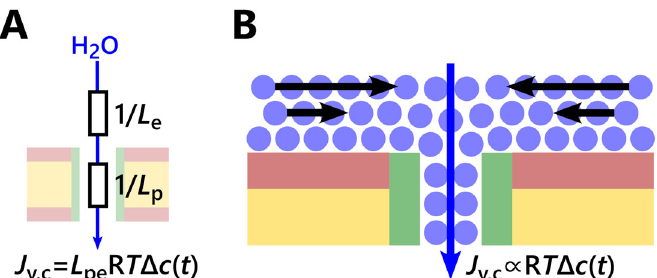
Figure 8. ( A ) Entrance effects may limit rapid water transport through selective water channels. The hydrodynamic resistance of the entrance region, 1/ L e , determines the rate at which water can be fed to the channel. 1/ L e is in series with the hydrodynamic resistance of the channel, 1/ L p , which is intrinsic to the channel and governed by interactions of intraluminal water molecules with the pore walls [14,34]. If L p exceeds L e , the water flux through the narrow channel, J v,c , is limited by L e (Equation (17)). ( B ) One way of rationalizing the access resistance for water is to consider the no-slip condition at the membrane–water interface. The further into the bulk, the more mobile the water molecules become, as indicated by the horizontal arrows. At the pore mouth, highly mobile water molecules are effectively depleted due to the osmotic gradient across the membrane, where R T ∆ c ( t ) is osmotic pressure across the vesicular membrane. Since (a) permeating water molecules have to be replenished from the surrounding and (b) interfacial water immediately adjacent to the pore mouth is slowed down, L e must depend on pore